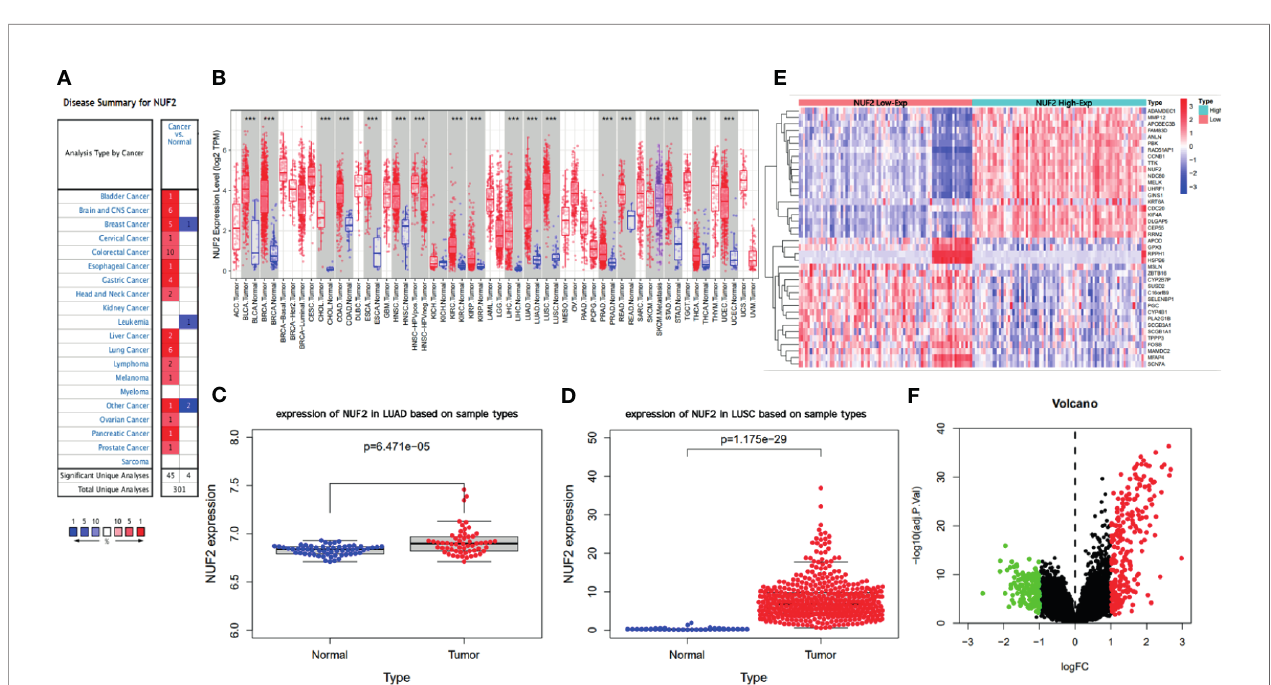
FIGURE 2 | Difference analysis of transcription levels for NUF2 in different type of tumor tissues and normal tissues. (A, B) The expression level of NUF2 in different type of tumor tissues and normal tissues via Oncomine and TIMER. (C, D) The NUF2 expression level of tumor tissues and normal tissues in NSCLC from TCGA data set and GEO data set (GSE32863). (E, F) Heatmap and volcano plot of mRNA expression changes based on NUF2 gene expression in NSCLC samples from GSE77803. ***p <